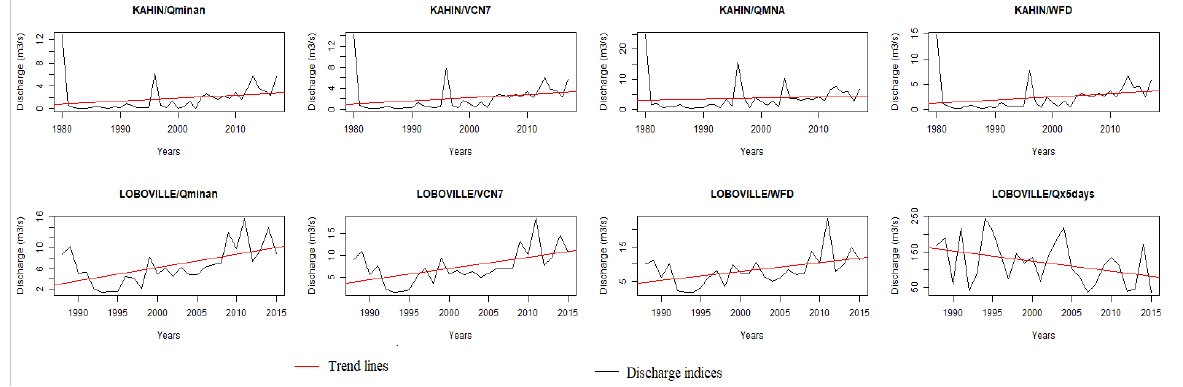
Figure 3. Stations and indices indicating significant trends (Qminan, QMNA, VCN7, WFD, and QX5-days) in the selected river watersheds in Côte d’Ivoire . Table 4. Break point detection related to flood and low-discharge indices in some watersheds in Côte d’Ivoire for the period 1980–2017.